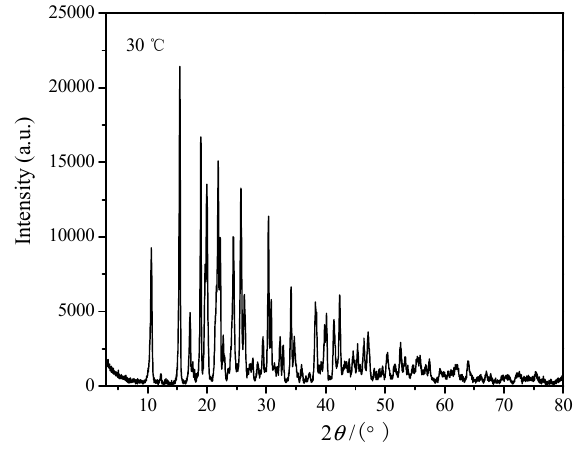
Figure 2. XRD pattern of [Zn 2 (btca)(H 2 O) 4 ].